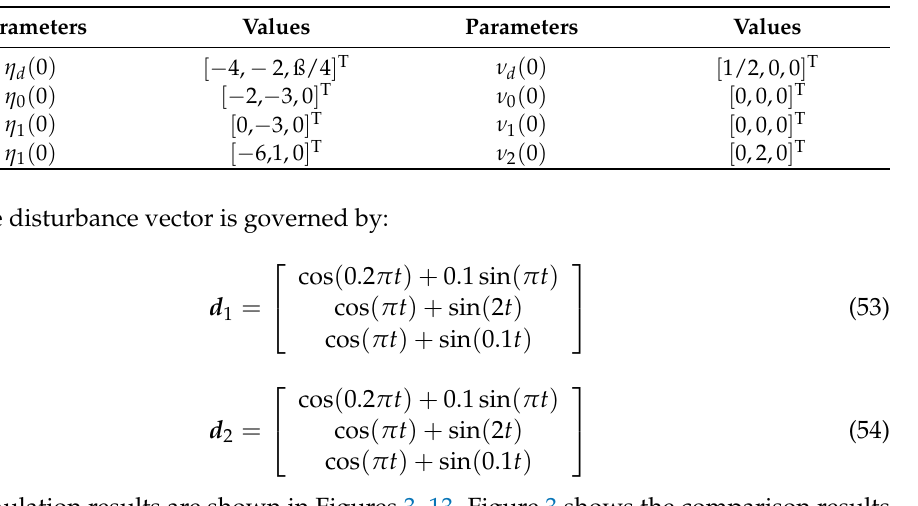
Table 4. Position and velocity